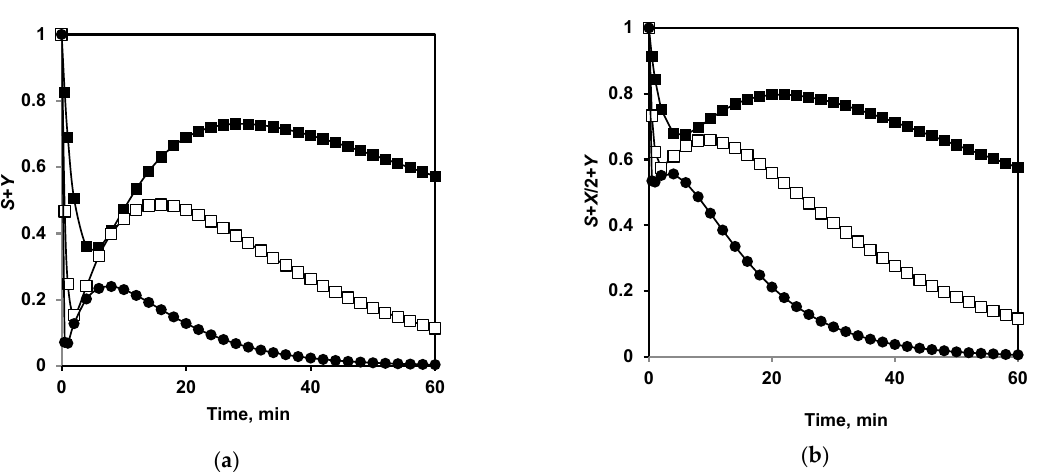
Figure 10. Prediction of the changes in secondary structures in course of proteolysis at different trypsin concentrations: E 0 = 0.25 mg/L, S 0 / E 0 = 1000 ( ▉ ) ; E 0 = 1 mg/L, S 0 / E 0 = 250 ( □ ); and E 0 = 4 mg/L, S 0 / E 0 = 63 ( ● ). ( a ) Secondary structures are assumed to be retained only in the original mi-